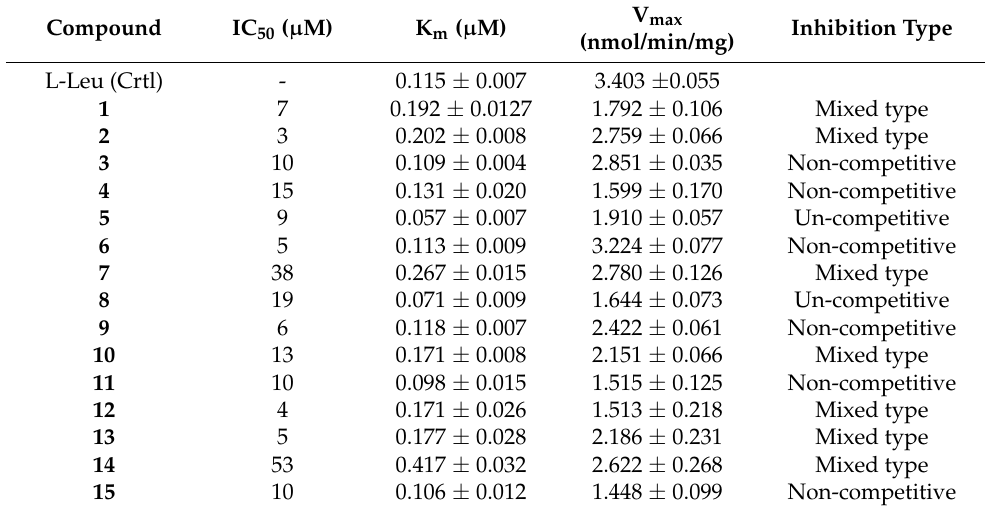
Table 2. Kinetic parameters (K m and V max ) of LAT1-mediated uptake inhibition of the probe substrate [ 14 C]-L-Leu (0.010–0.20 µ M) and the concluded inhibition type of LAT1-utilizing compounds 1 – 15 studied with immortalized mouse microglia (BV2). The data are presented as mean ± SD, n = 3–4. V max Inhibition Type Compound IC 50 ( µ M) K m ( µ M) (nmol/min/mg) L-Leu (Crtl) - 0.115 ± 0.007 3.403 ± 0.055 1 7 0.192 ±